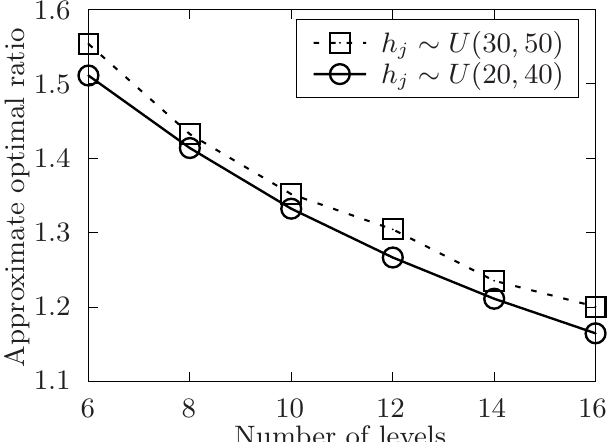
Figure 10. The approximate optimal ratio of the proposed algorithm vs. different n when h j ∼ U ( 20,40 ) or U ( 30,50 ) .